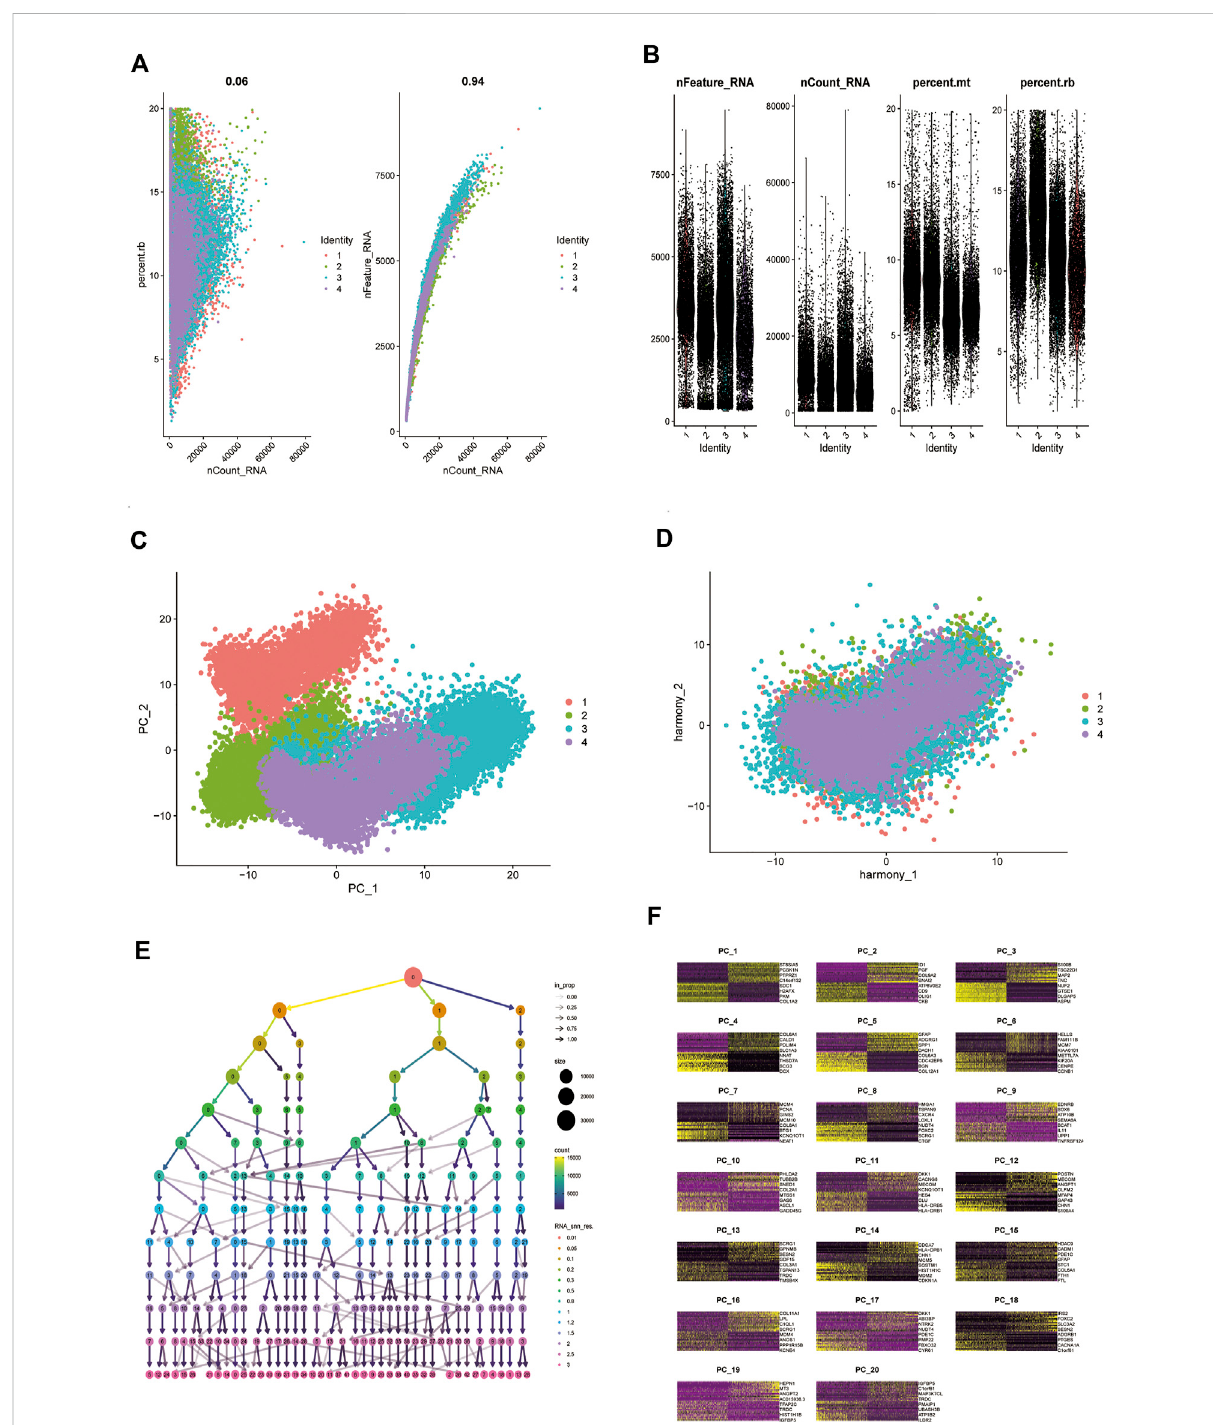
FIGURE 8 Comparison of single-cell analysis before and after normalization. (A,B) Quality control analysis of single-cell data sets. (C,D) Plots of principal component analysis (PCA) before and after standardization. (E,F) Resolution with principal components (PCs) to be con fi